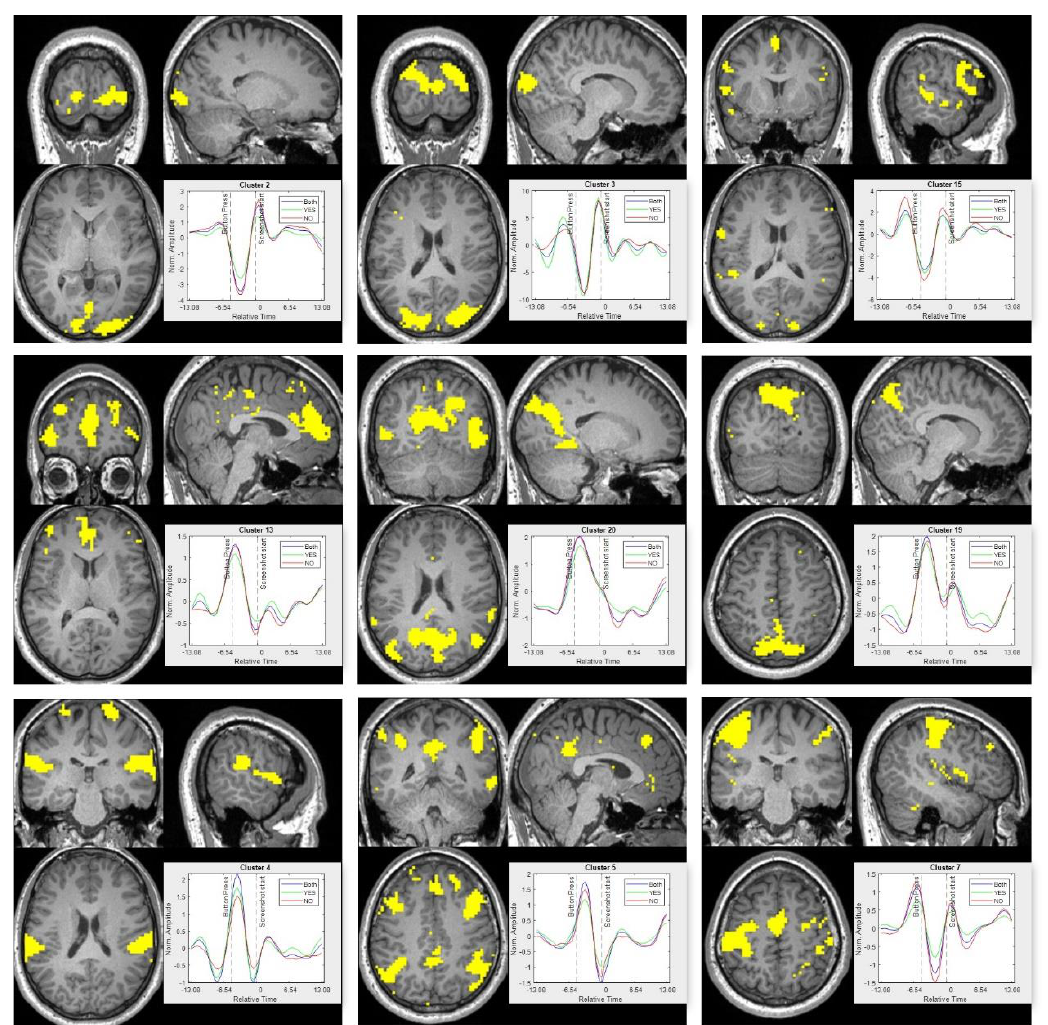
Figure A8. Spatial and temporal results for L1 regularization of the first difference. The spatial maps correspond to k-means clusters. The cluster numbers are indicated on top of the time series subplot. The temporal plot shows the mean response of the clusters to ‘YES’ apps (green), ‘NO’ apps (red) and ‘all’ apps (blue). The temporal response is centered at the beginning of the new trial. The instance of a button press and beginning of new trial is indicated with dotted lines.